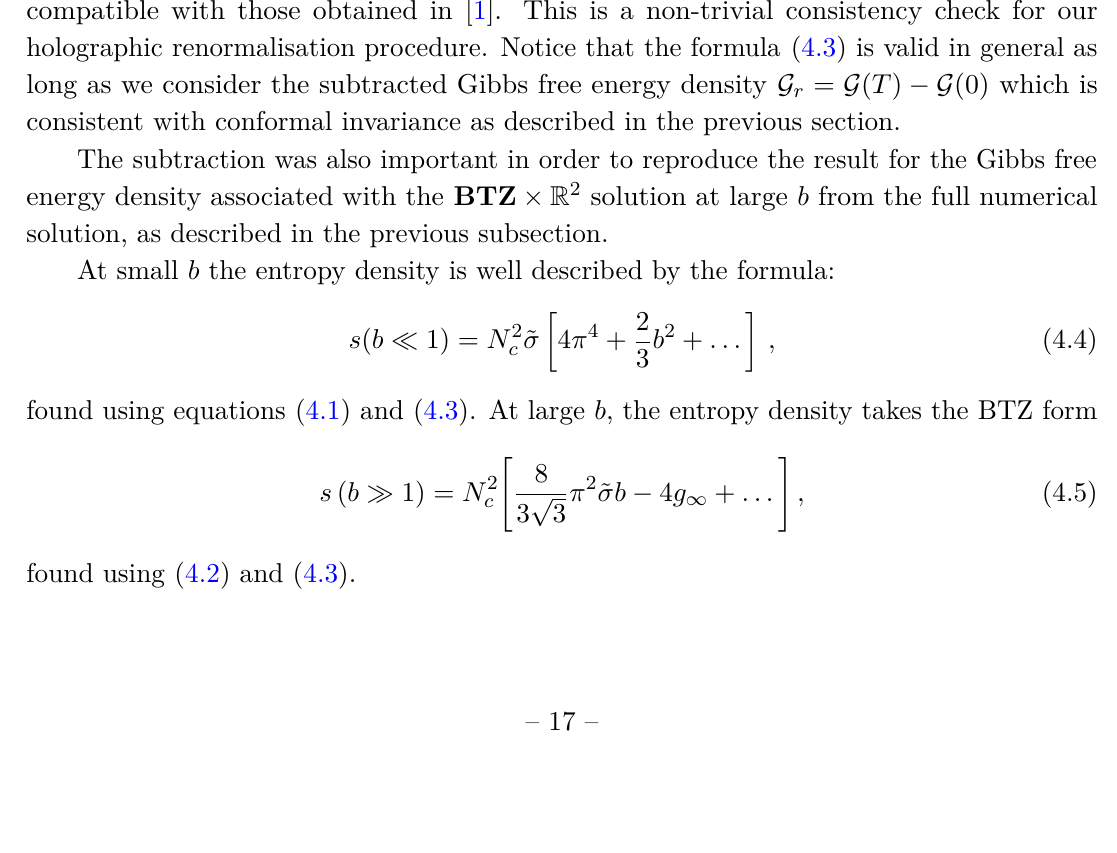
Figure 2 . The dimensionless free energy density g r = G r /T 4 (solid blue line), divided by N 2 function of b = B /T 2 , compared with the analytical solution at small b (orange dashed line) and large b (red dashed line). The analytical solutions at small b and large b , shown in equations (4.1) and (4.2), were obtained in appendices A and B respectively. The green dashed line depicts the limit at b = 0